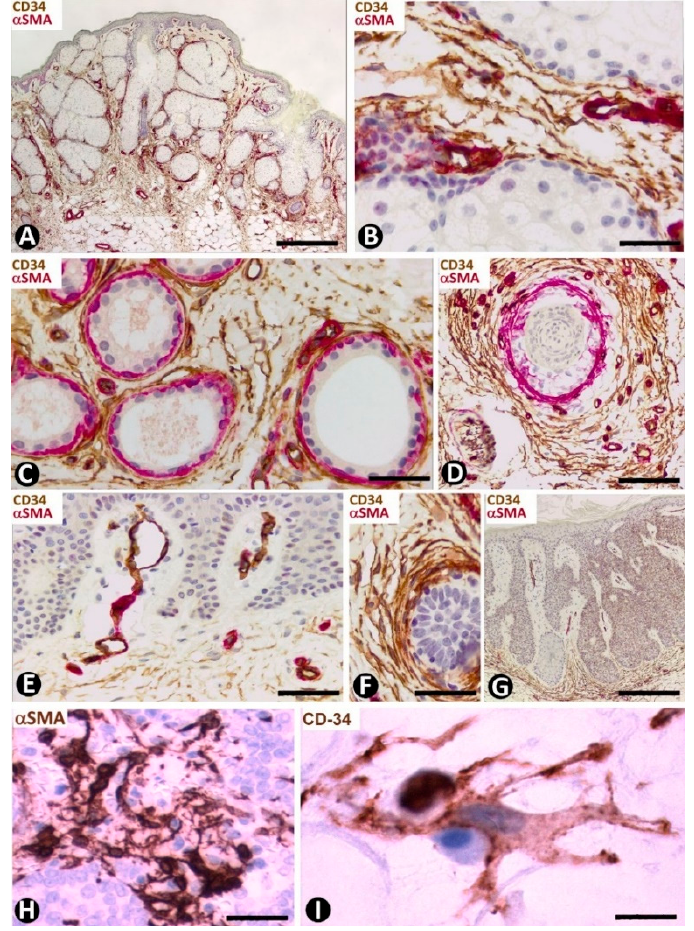
Figure 16. Nevus sebaceous of Jadassohn ( A – F ), seborrheic keratosis ( G ) and Merkel cell carci- noma ( H , I ). ( A – G ) Double immunochemistry for CD34 (brown) and α SMA (red). Haematoxylin counterstain. ( H , I ) Immunochemistry for α SMA ( H ) and CD34 ( I ). ( A ) Panoramic view showing hyperplasia of superficially located sebaceous glands. Note that one gland opens through the epidermis. ( B – D ): Numerous CD34+SCs/TCs around sebaceous glands ( B ), sweat glands ( C ) and an involutive hair follicle in the lesion ( D ). ( E ) Absence of perivascular and interstitial CD34+SCs/TCs in areas with papillomatosis. ( F ) Abundant CD34+SCs/TCs around a basaloid proliferation. ( G ) Seborrheic keratosis in which CD34+ stromal cells are located at the bottom of the lesion, but are not observed in papillary areas with papillomatosis. ( H , I ) Merkel cell carcinoma with stromal cells, which show an increased somatic region and voluminous nuclei, and express α SMA ( H ) and CD34 ( I ). Bar: ( A , G ) 150 µm, ( B , H ) 45 µm, ( C – F ) 80 µm, I 15 µm.